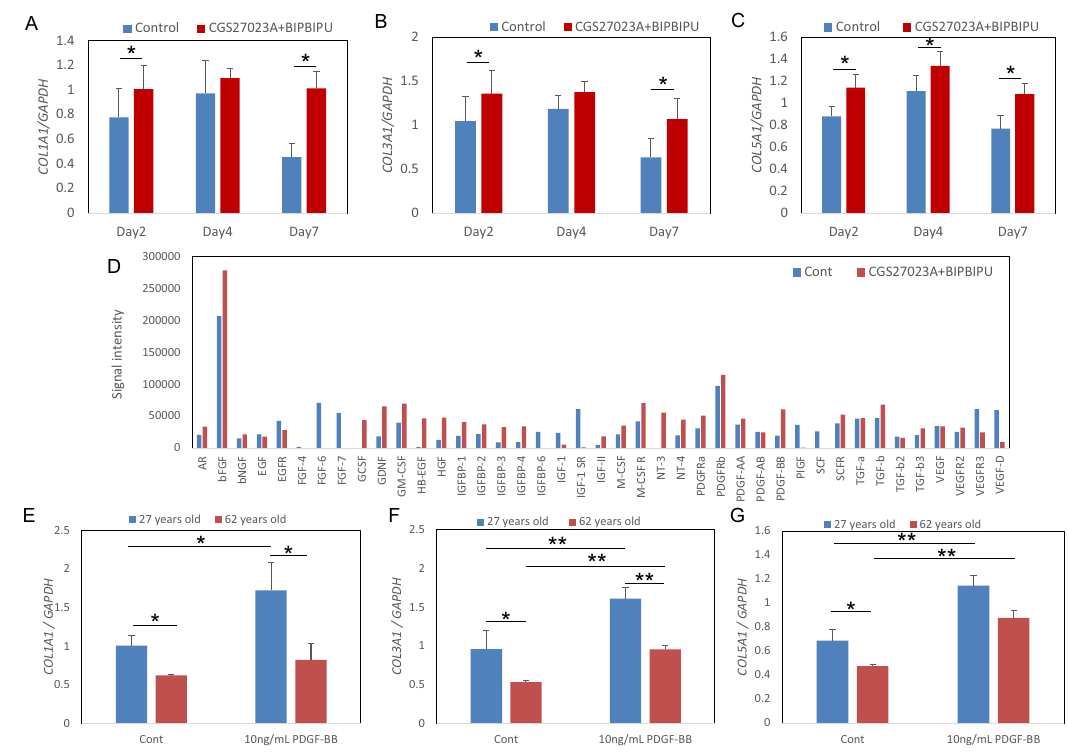
Figure 5. Promotion of collagen expression in fibroblasts by conditioned medium from the skin equivalent model. mRNA expression levels of the COL1A1 ( A ), COL3A1 ( B ) and COL5A1 ( C ) genes in cultured fibroblasts cultured with conditioned media from the skin equivalent model were analyzed by qPCR. Data are expressed as mean ± SD of three independent experiments. * p < 0.05. Protein membrane array analysis was performed by using the cell lysate from epidermis of the skin equivalent model cultured with MMP inhibitor CGS27023A and heparinase inhibitor BIPBIPU ( D ). mRNA expression levels of the COL1A1 ( E ), COL3A1 ( F ) and COL5A1 ( G ) genes in cytokine-stimulated fibroblasts were analyzed by qPCR. Data are expressed as mean ± SD of three independent experiments. *p < 0.05, **p <